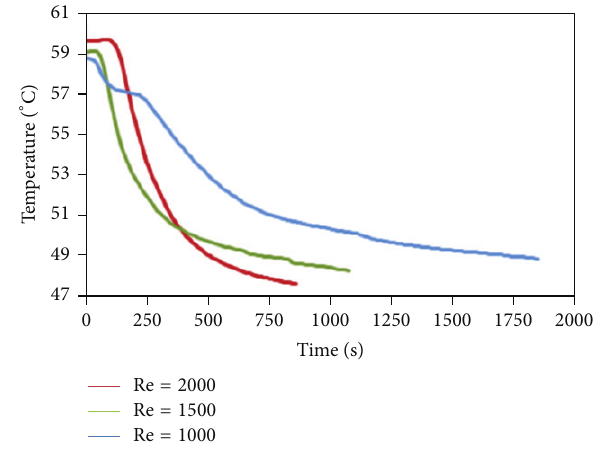
Figure 5: Temperature measurement records in the solidification process for Re = 1000, Re = 1500, and Re = 2000.